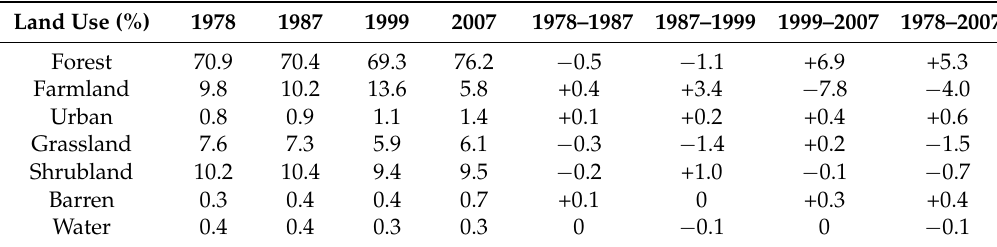
Table 4. Percent of land use areas and changes in the Upper Du Watershed